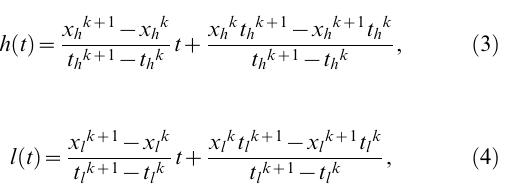
where x hk and x lk represent bioluminescence at the k th peak and k th bottom of the time series in each pixel, t hk and t lk stand for occurrence time of the k th peak and k th bottom, and t hk # t , t hk + 1 and t lk # t , t lk + 1 . To remove the noise included in the biolumines- cence data, moving average filter with 6 h window size was applied. Then peaks and troughs were identified as local maxima and local minima of the smoothed data, respectively. Figure S1 Spatial fluctuations of bioluminescence and phase on the surface of cultured SCN slice. (a) Intensity of bioluminescence x during a circadian cycle (48 h to 72 h). The white rectangle corresponds to the region enlarged in Figs. S1b and S1c. (b), (c) Binary patterns of the spatially detrended bioluminescence d x and phase dh at t = 58, 82, 106 h. White color indicates d x . 0 or dh . 0, whereas black color indicates d x , 0 or dh , 0. Figure S2 Per2::Luc bioluminescence rhythms in thin SCN slices. Representative Per2::Luc rhythms in the SCN slices at the thickness of 150 m m (a) and 100 m m (b), respectively. Note that the amplitude of the Per2::Luc fluctuation is significantly lower and the rhythmicity does not persist long in (b) as compared to (a). Bioluminescence intensities are comparable between the two slices, suggesting that the discrepancy is not caused either by slice preparation or culture condition.